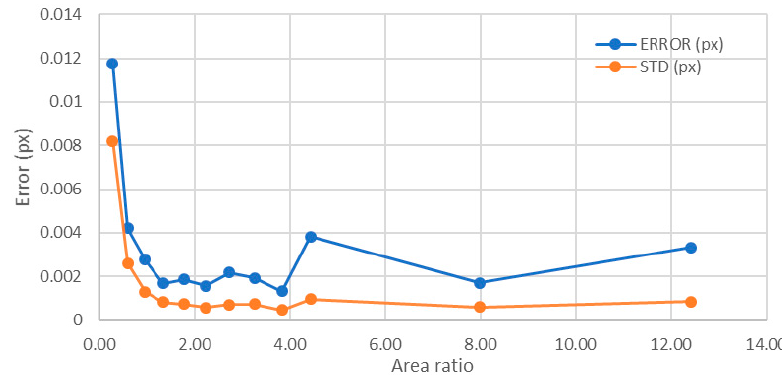
Figure 14. Influence of the area ratio for a point radius of 25 px (from 0 to 256 levels).